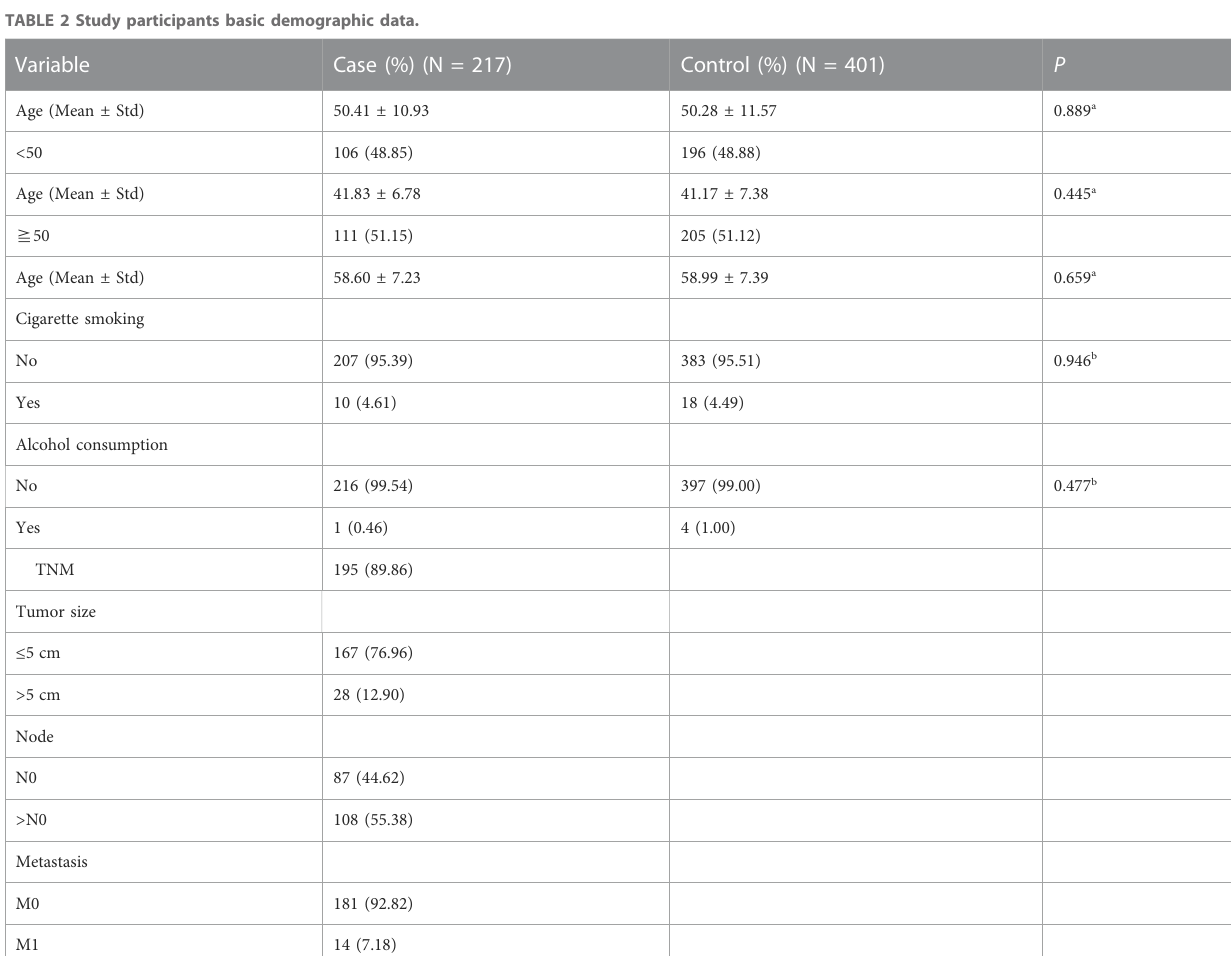
TABLE 2 Study participants basic demographic